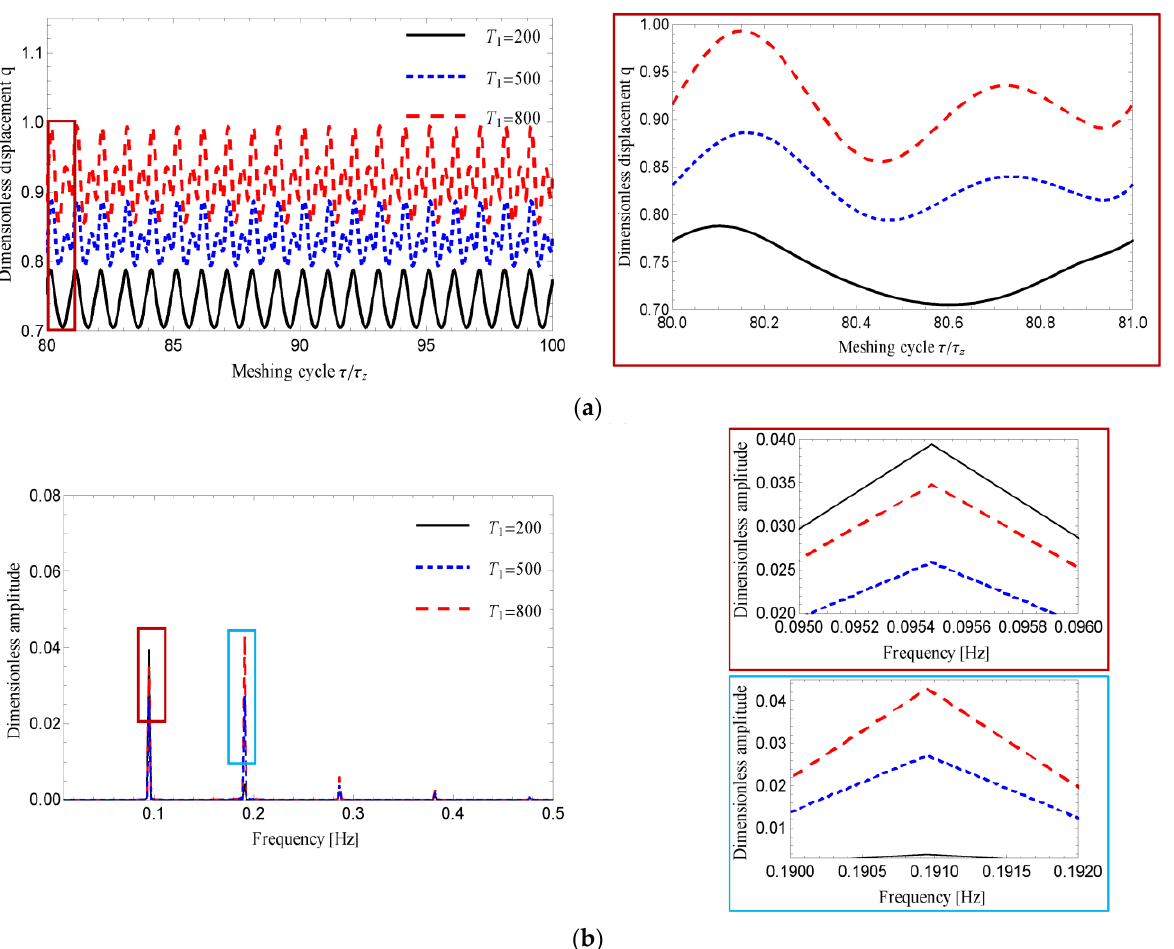
Figure 22. The dynamics characteristics with differen t 𝑇 1 : ( a ) time history diagram; ( b ) FFT spectrogram.